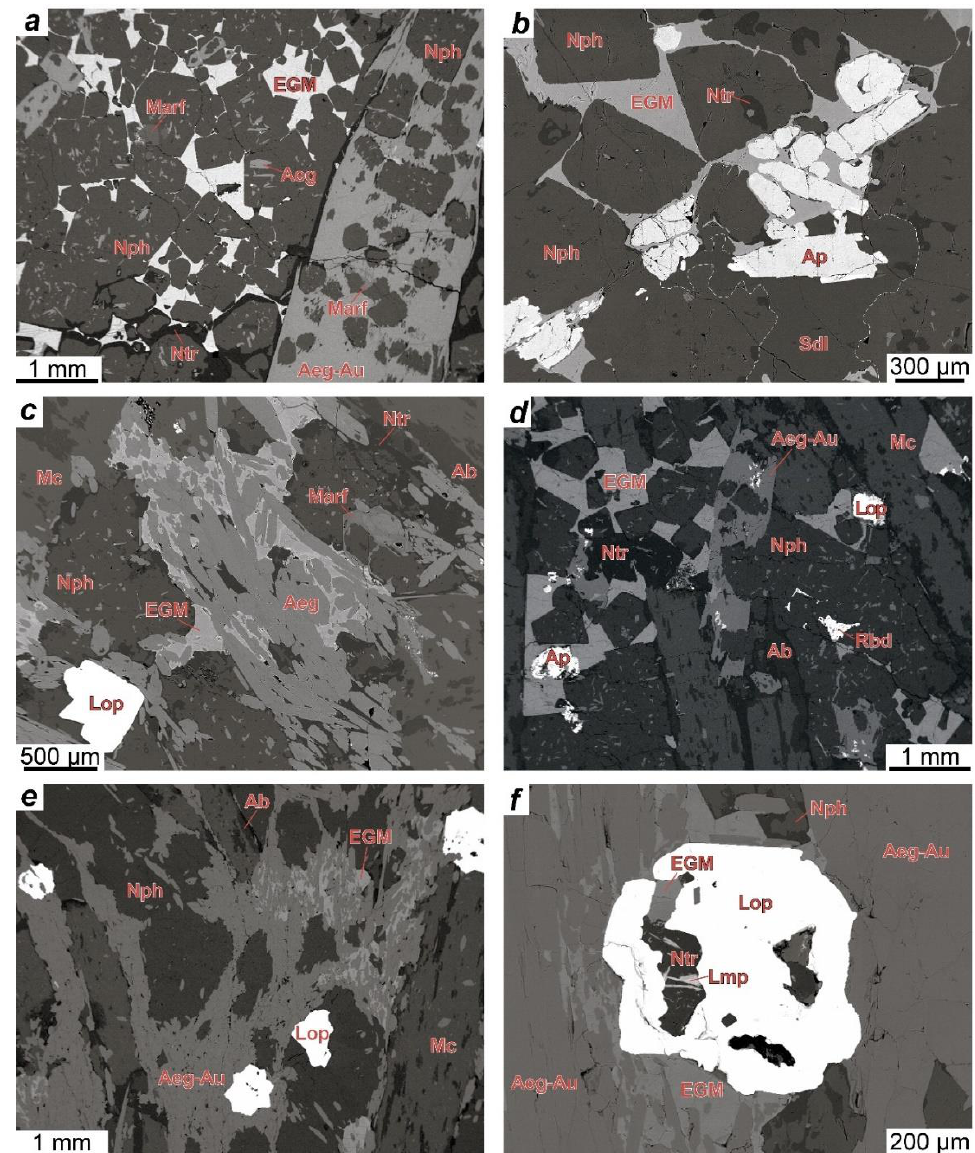
Figure 3. BSE–images. Morphology of the EGM from the Layered complex of the Lovozero massif. In all types of rocks, the anhedral EGM grains fill the interstices of rock-forming minerals. ( a ) Urtite LV-01-54 (Mt. Kitknyun); ( b ) urtite LV-IV-2-2 (Mt. Kedykvyrpakhk); ( с ) ijolite LV-III-2-2 (Mt. Kedykvyrpakhk);